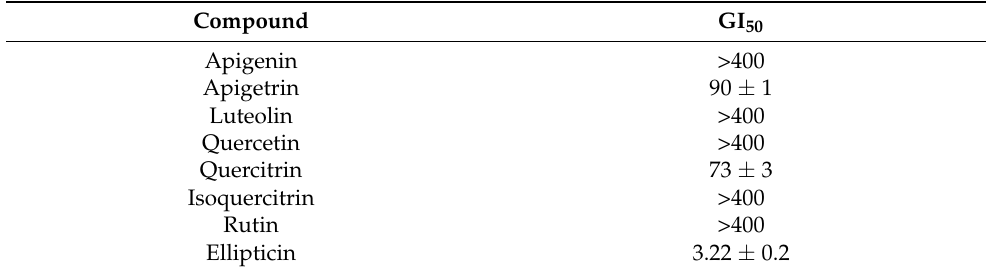
Table 2. Cytotoxicity of tested compounds, GI 50 (compound concentration that inhibited 50% of the net cell growth) expressed in µ